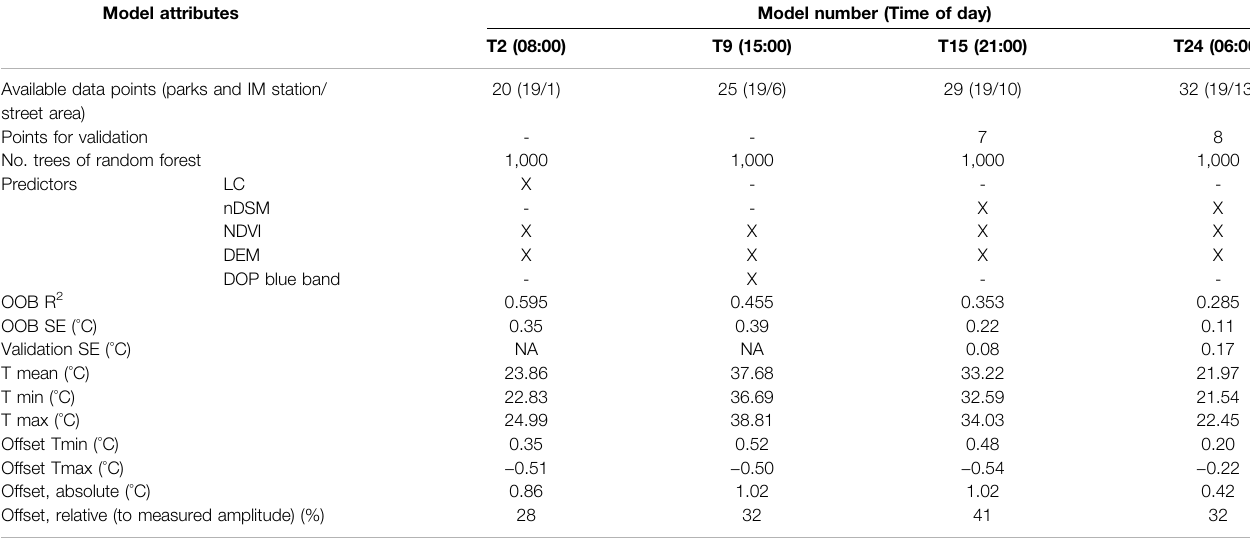
TABLE 2 | Attributes of selected random forest models. Model attributes